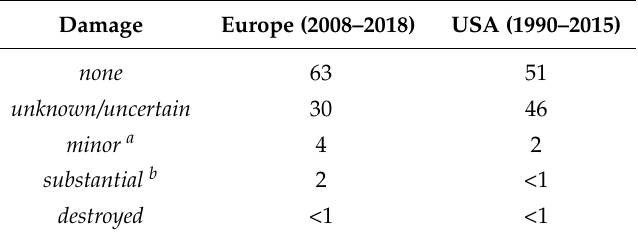
Table 4. Magnitudes of damage resulting from bird strikes in Europe and the US in percentages